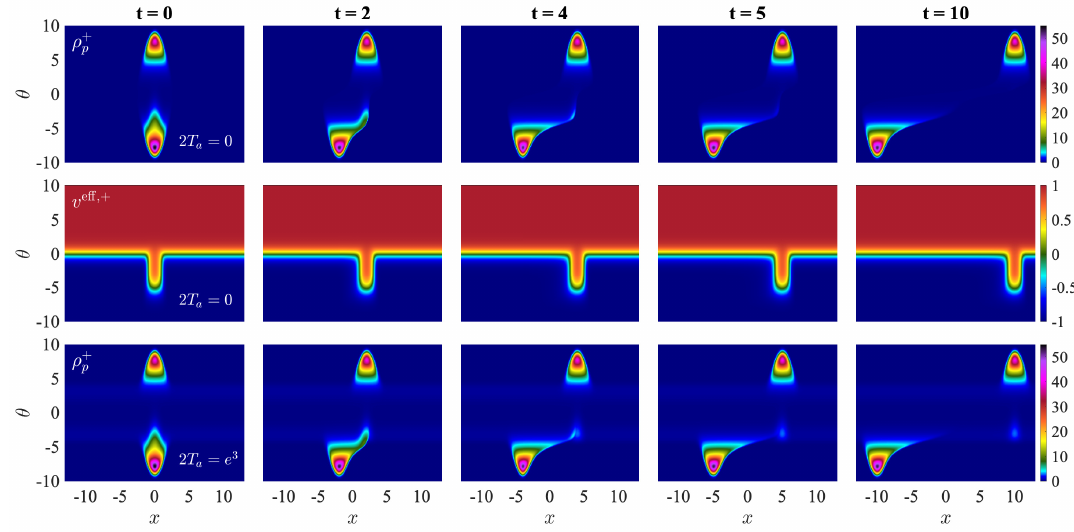
( x, t, θ ) in the absence T = 0 (1st row) and in the presence Figure 1 . Spectral density ρ + a p log(2 T ) = 3 (3rd row) of a bath for the initial condition (1.6). In both cases log(2 T ) = 7 . 5 and a m σ = 12 so that κ = 1 . 5 . The three local maxima of the spectral density are clearly visible, particularly for t ≥ 4 when they are all well separated. They are centered around θ = ± log(2 T ) = ± 7 . 5 and m θ = log(2 T m ) − σ = − 5 . 5 . The smallest maximum (subsidiary peak) is seen to fully decay into a tail in the first row, whereas it partially persists in the third row. The second row shows the effective velocity for the case of no bath (it is nearly identical with a bath). For fixed x , the velocity profiles are mostly tanh θ -like, except for a small region of values around the subsidiary peak, where the generic tanh -shape is shifted by − σ/ 2 = − 5 . Between these two regimes the effective velocity develops intermediate